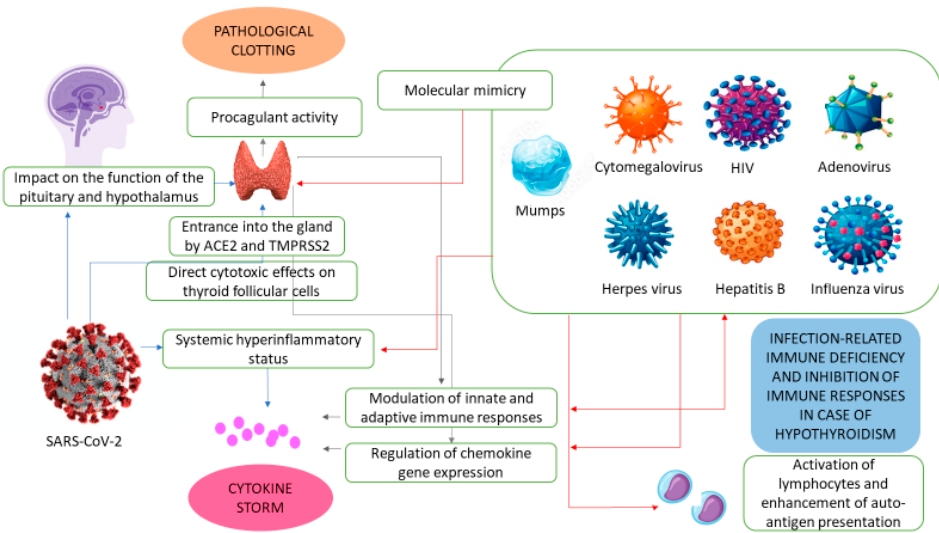
Figure 1. Main proposed mechanisms underlying the relationship between SARS-CoV2-2 and other viruses and the thyroid gland. Blue arrows indicate actions performed by SARS-CoV2-2; gray arrows indicate actions performed by the thyroid; red arrows indicate actions performed by other viruses. See text for details. Abbreviations: ACE2: angiotensin-converting enzyme 2; TMPRSS2: transmembrane serine protease 2.